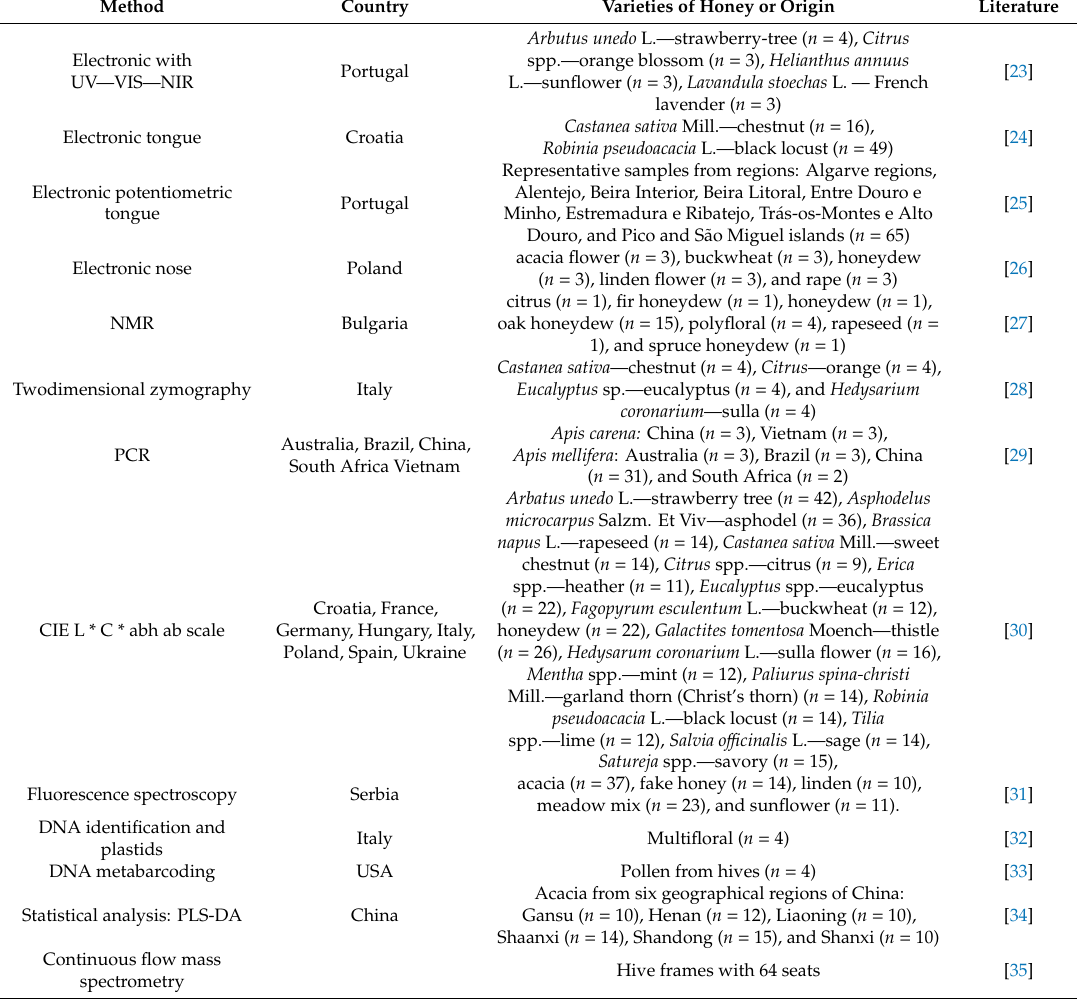
Table 2. Selected methods for determining type and variety of